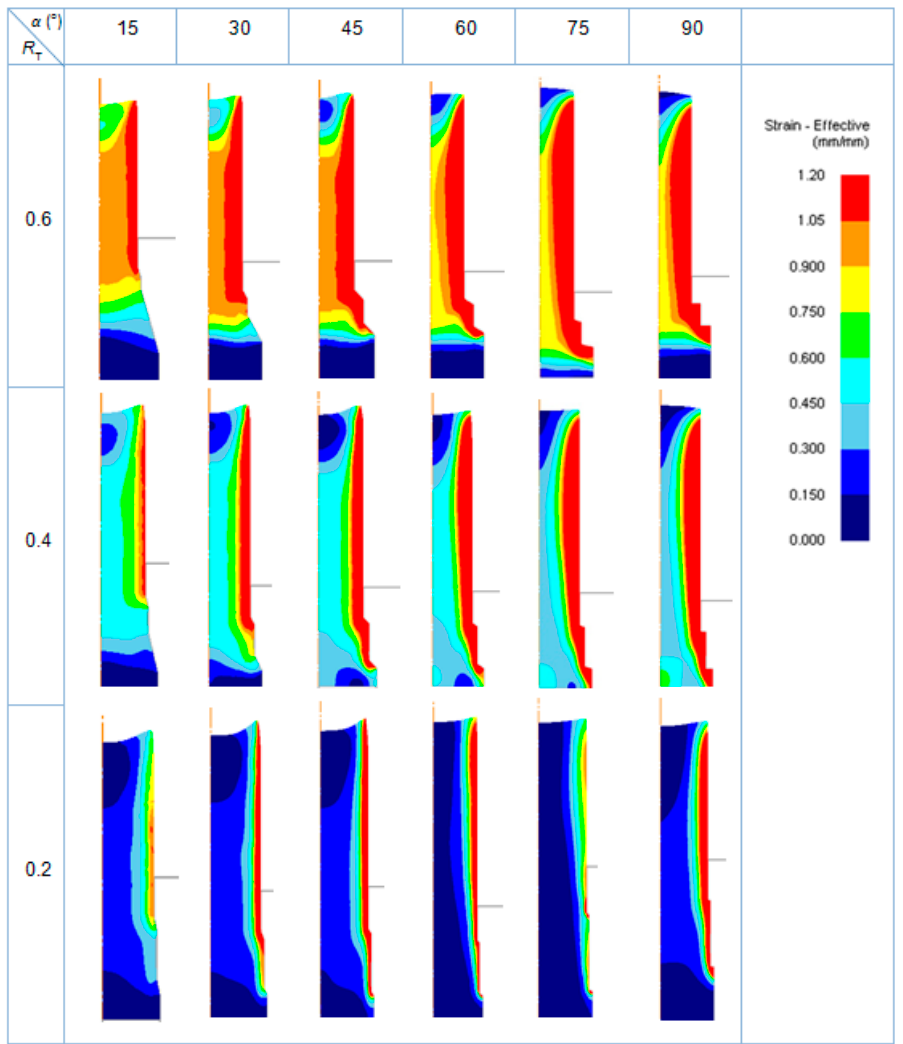
Figure 16. Effective strain diagrams for the best configurations of double-pass dies in cold extrusion of dual-phase steel DP800.